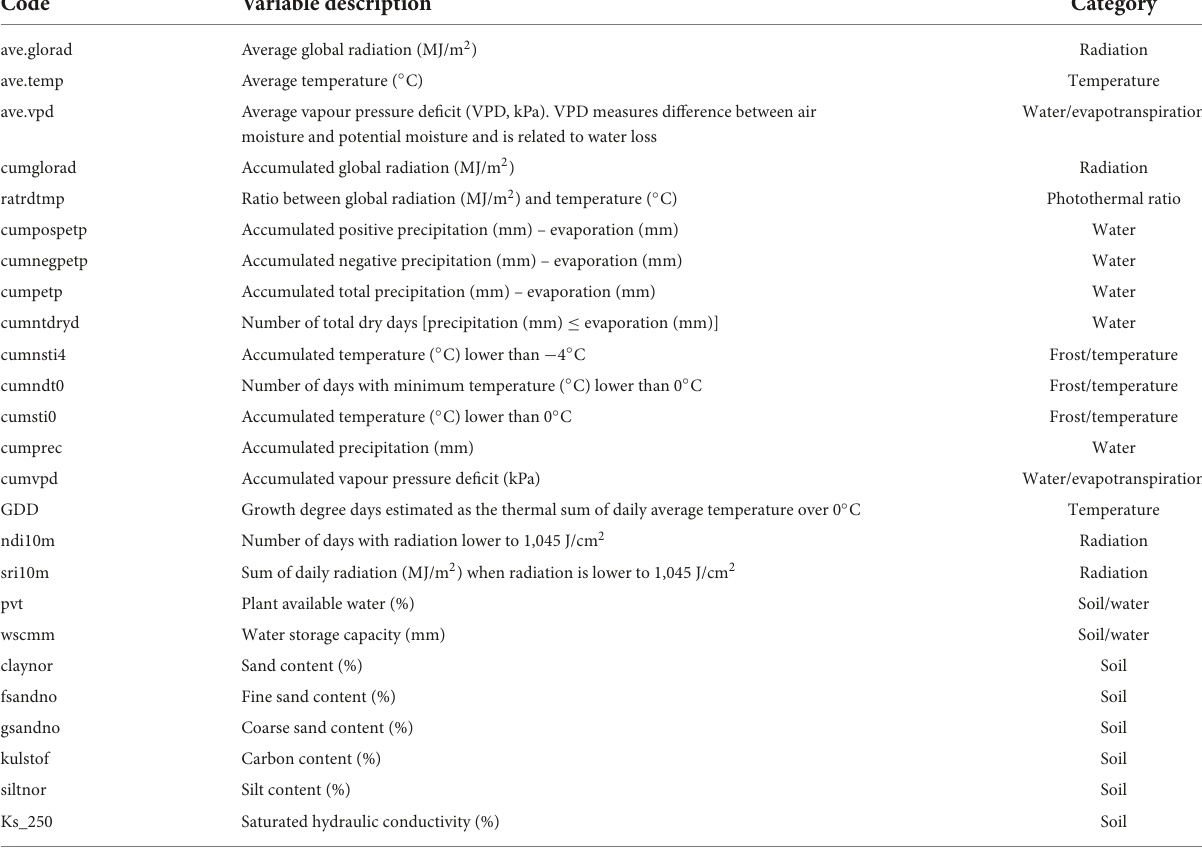
TABLE 1 Environmental covariates (ECs) description, modified from Lecomte (2005) and Heslot et al.